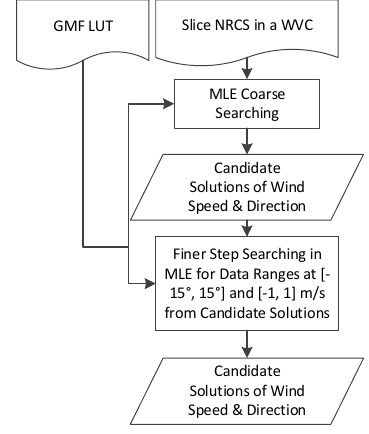
Figure 4. Wind inversion procedures of a wind vector cell (WVC) for on-board processing.